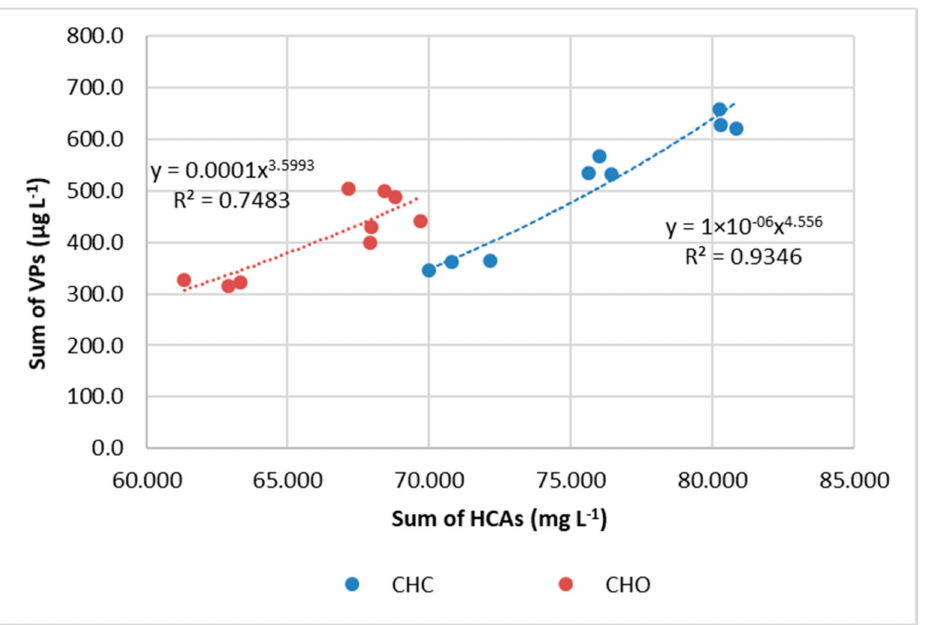
Figure 3. Correlation between the content of the volatile phenolics (VPs) in the Chardonnay experimental variants and the sum of the hydroxycinnamic acids (HCAs), vintages